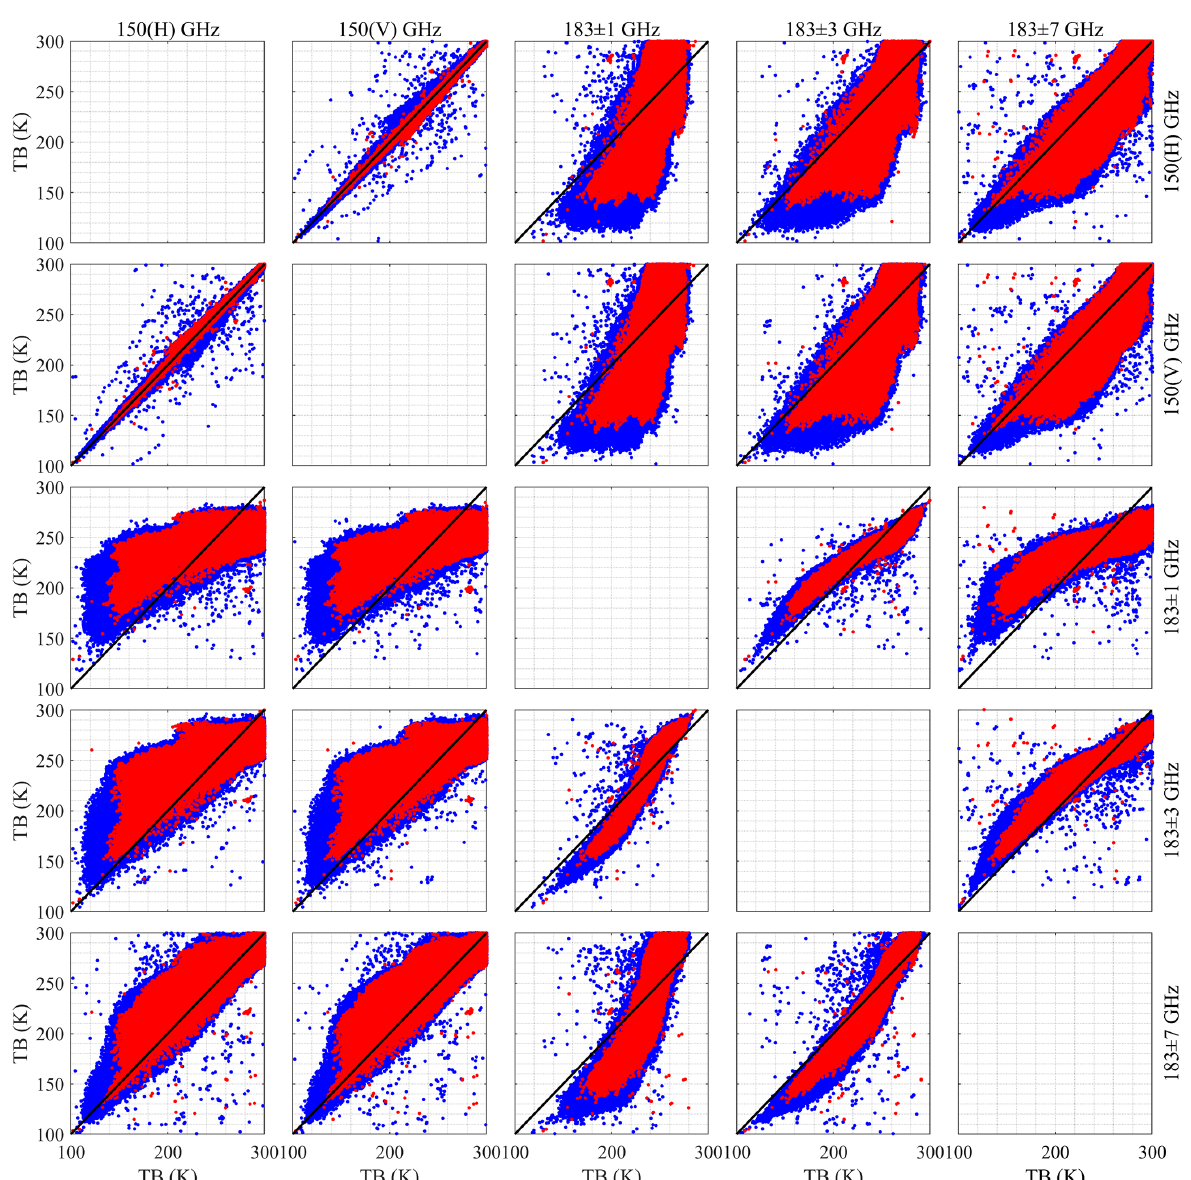
Figure 13. Measurement comparison from different channels of MWHS dataset in 2015 (blue) and the collocation dataset discussed above